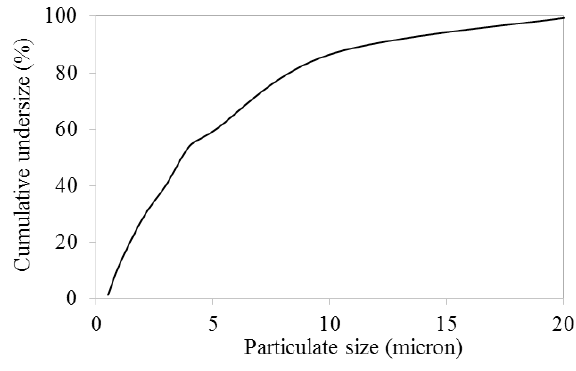
Figure 1: Cumulative undersize values of the ultra-fine calcite